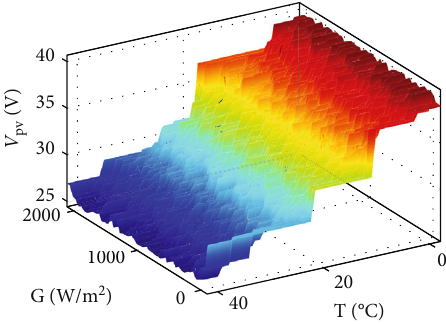
Figure 7: Maximum voltage of PV array at changing G and T